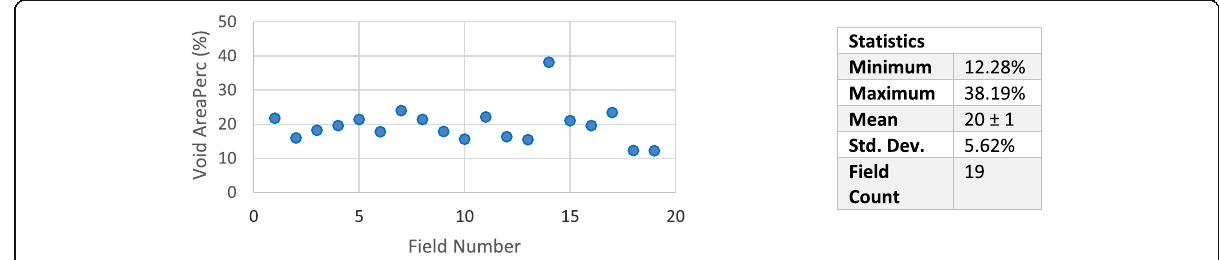
Fig. 12 Image analysis with statistic calculation of the amount of porosities found in the microsection of the